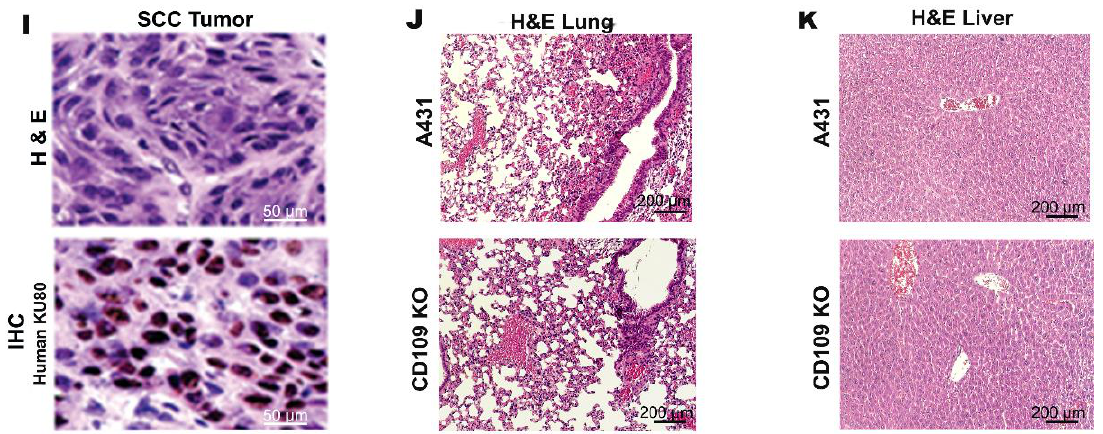
Figure 1. The loss of CD109 prevents tumorigenicity of A431 SCC cells in vivo. ( A , E ): A diagram of tumor Xenograft experiments. ( B , F ): The images of xenograft tumors from SCID mice injected with A431 (A431 CD109 wild type) or A431 CD109 KO cells as indicated. ( C , G ): Weight of xenograft tumors from SCID mice injected with A431 and CD109KO cells as indicated. ( D , H ): The growth (volume) curves of xenograft tumors derived from A431 or CD109KO cells as indicated. A 1:1 PBS/Matrigel (volume) was used as control. ( I ): Representative histology images of the lung tumor sections from control A431 cell tumors, as detected by hematoxylin-eosin (H&E) staining (Top). Sections were also subjected to immune-histochemical staining with anti-Human Ku80 (Bottom). (Note: Typical SCC has nests of squamous epithelial cells arising from the epidermis and extending into the dermis. The malignant SCC cells are often large with abundant eosinophilic cytoplasm and a large, often vesicular, nucleus. KO 32 clone represents A431 cells with CD109 deletion using CRISPR knock out strategy as described in methods). ( J ): Representative images of H&E histologic staining of lung sections. ( K ): Representative images of H&E histologic staining of liver sections. All the results are expressed as the mean ± S.D. Significance was calculated using a One-Way ANOVA *** p <